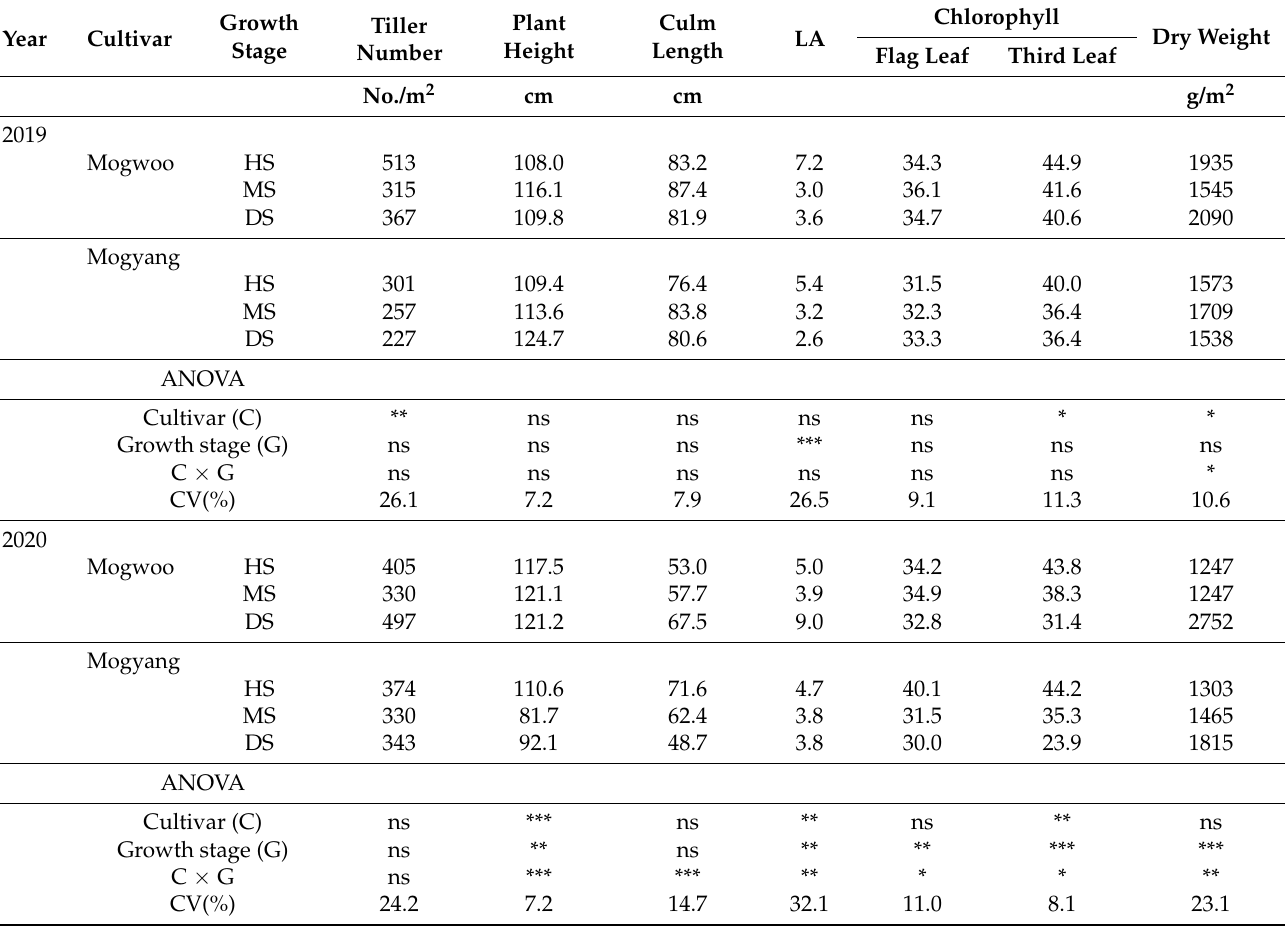
Table 4. The growth characteristics of ‘Mogwoo’ and ‘Mogyang’ in accordance with the growth stage for two